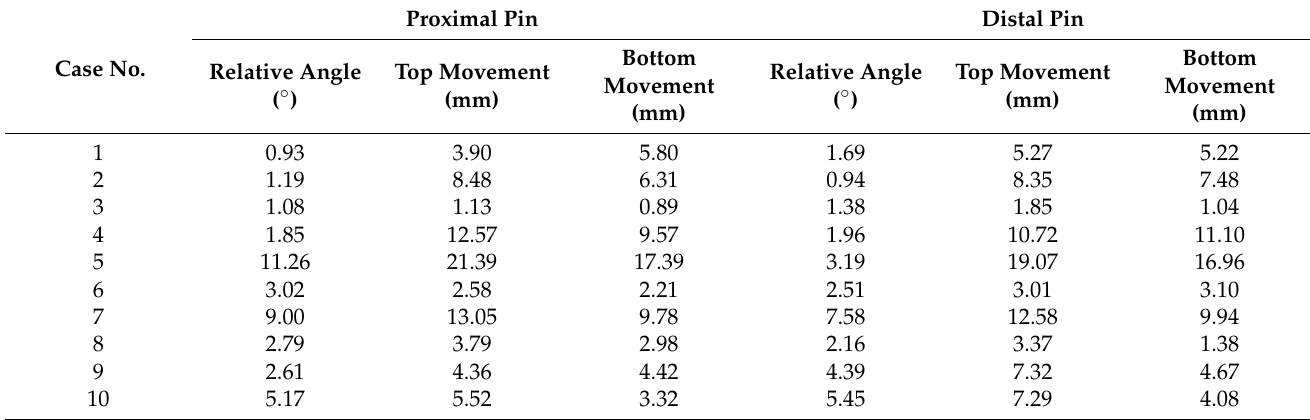
Table 6. Displacement of the Hansson pins.